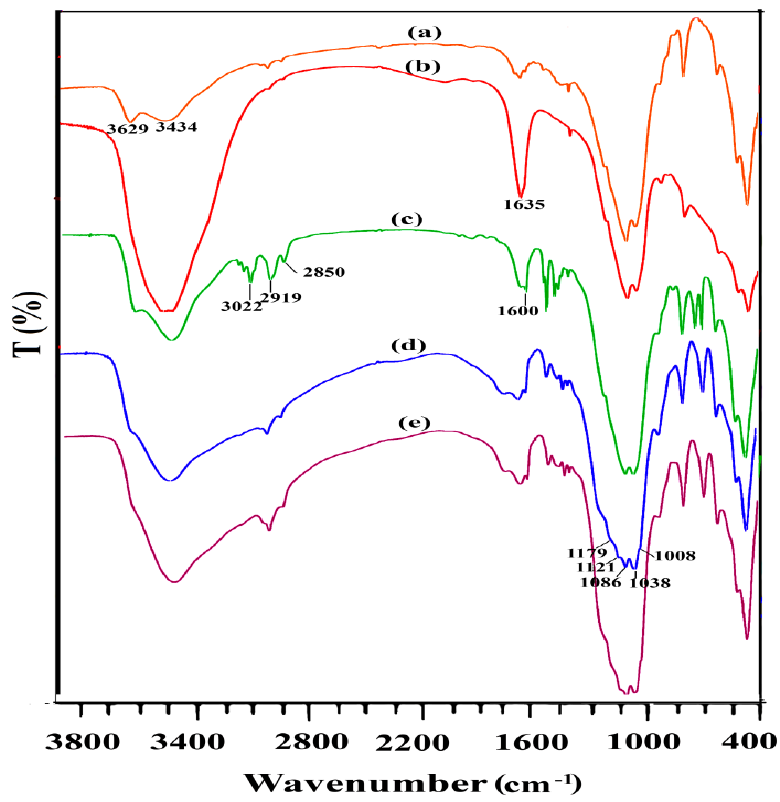
Figure 3. Fourier transform infrared spectra of ( a ) Raw BEN ( b ) H ‐ BEN, ( c ) Ar ‐ BEN, ( d ) AS ‐ BEN, and ( e ) spent AS ‐ BEN.